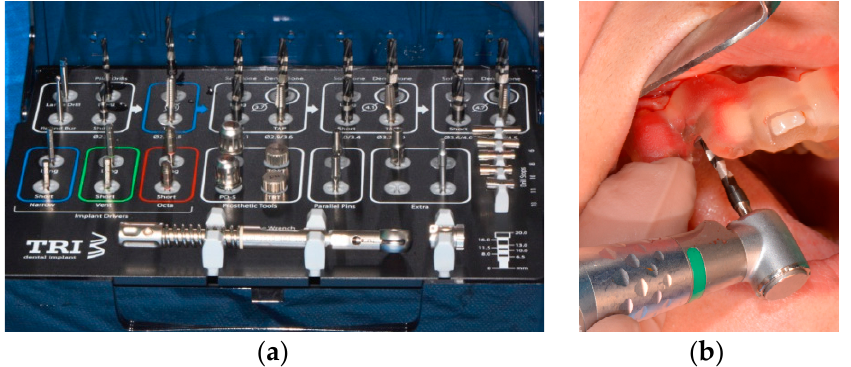
Figure 6. ( a ) Surgical cassette TRI dental implants; ( b ) implant bed preparation with tapered drills using a surgical template.